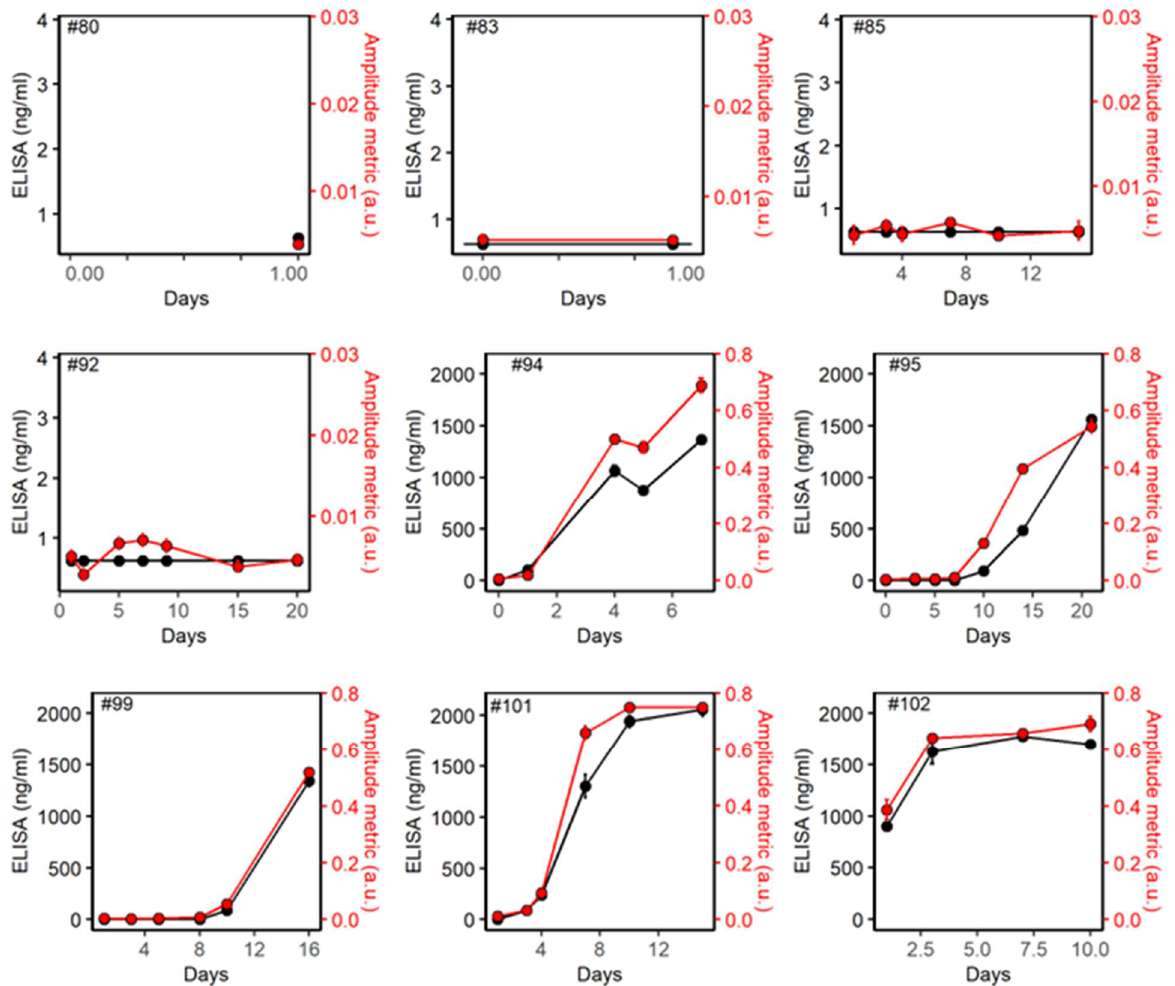
Figure 2. Plots for IgG antibodies. ELISA (y1 axis) and IgG amplitude metrics (y2 axis) with respect to days of ICU for COVID− (IDs #80, 83, 85 and 92) and COVID+ (IDs #94, 95, 99, 101 and 102) participants. Individual data points show mean ± standard deviation of 2 measurements for ELISA and 3 measurements for thermo-photonic methods.